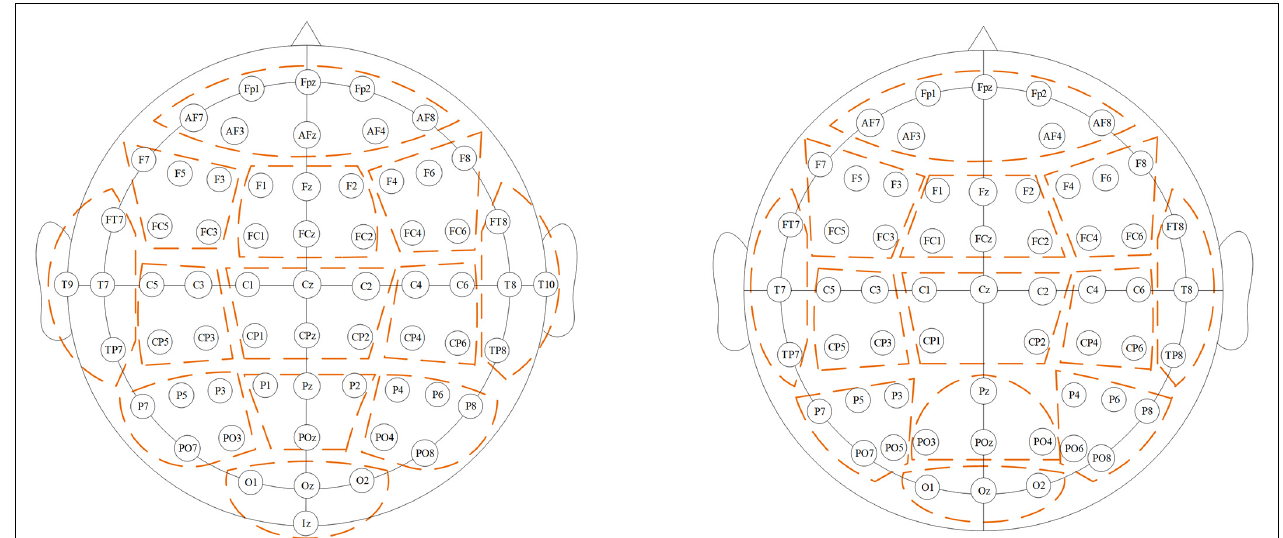
FIGURE 1 | Region division. Channels belonging to a region are circled with the dotted line. The left subfigure shows the division for DS1 and DS2, while the right subfigure shows the division for DS3.